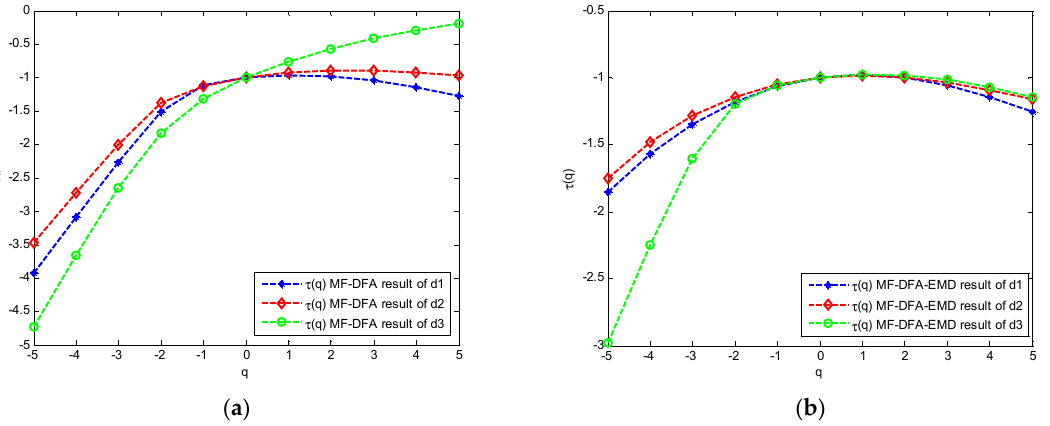
Figure 8. 𝑞 − 𝜏(𝑞) curves of three signal components obtained using: ( a ) the traditional MFDFA algorithm; and ( b ) the new MFDFA algorithm.